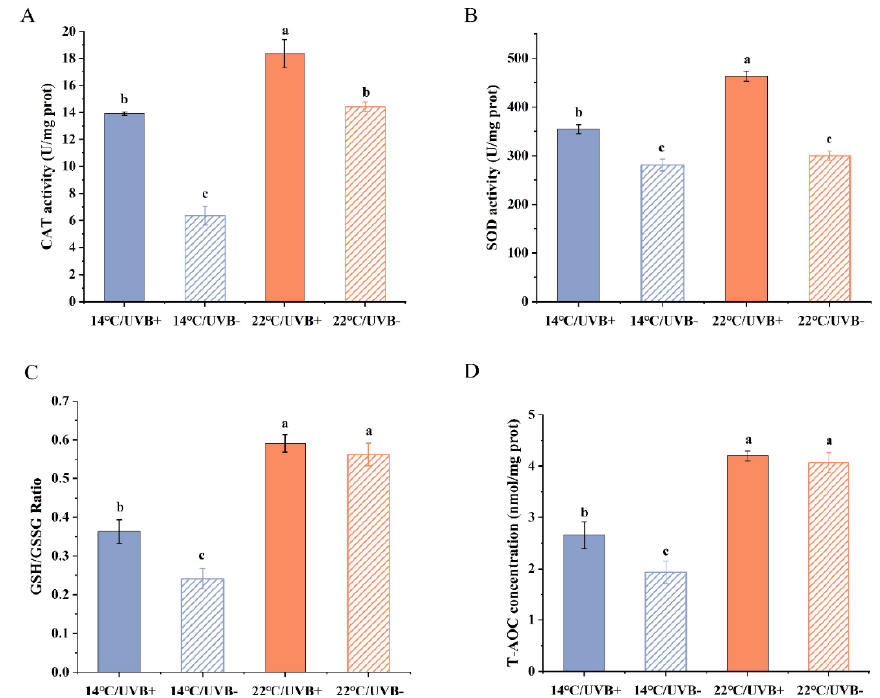
Figure 4. Effect of UVBR (solid bars) and UVBR–free (patterned bars) environments in combination with a 14 (blue bars) or 22 °C (red bars) temperature on the CAT activity ( A ), SOD activity ( B ), GSH/GSSG ratio ( C ), and T-AOC ( D ) in whole-body Rana kukunoris tadpoles. Data are presented as means ± standard error. Lowercase letters above bars denote significant differences between treatments.